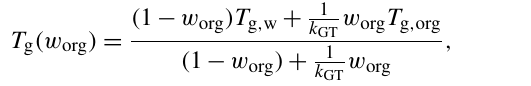
where ξ is an empirical fit parameter with the value of 0.93 (Evoy et al., 2019), η c is the crossover viscosity with the value of 10 − 3 Pa s and D b, c is the crossover diffusion coeffi- cient at η c = 10 − 3 Pa s as determined by the Stokes–Einstein equation (Eq.